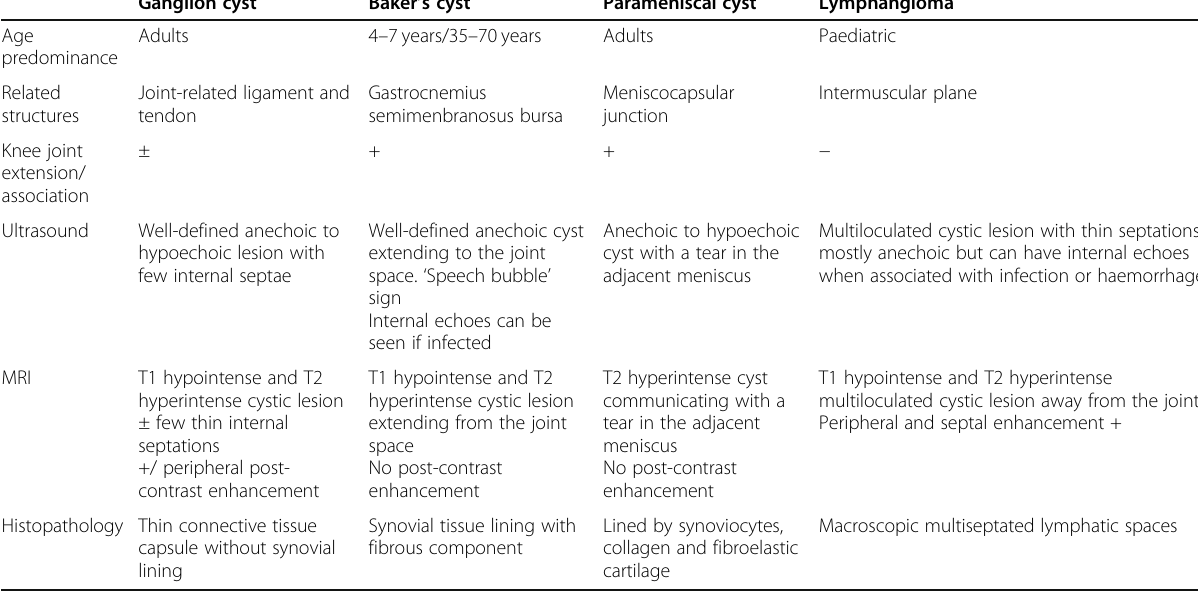
Table 1 Differential diagnosis for cystic lesions in and around the popliteal